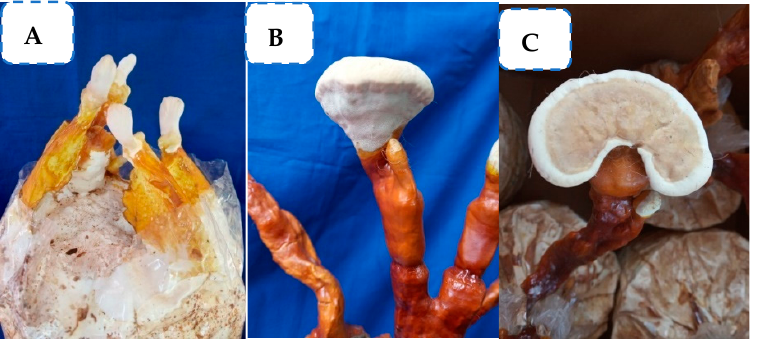
Figure 1. Production of the fruiting body of G. lucidum. ( A ) Elongation of stipe; ( B ) expansion of fruiting body; and ( C ) bracket-shaped fruiting body.